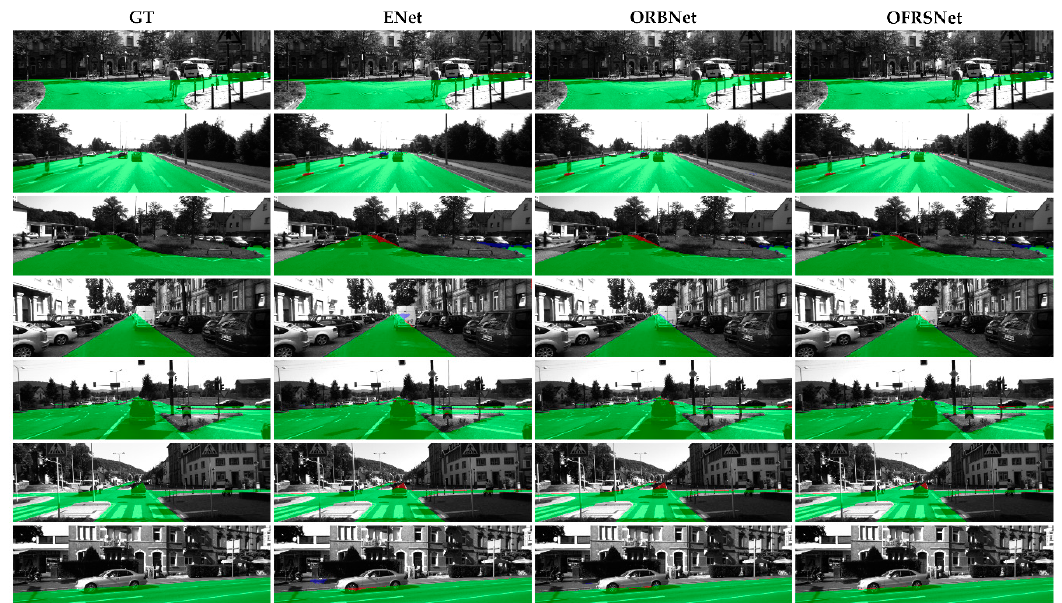
Figure 8. Qualitative results on the KITTI-OFRS dataset. The columns from left to right are the results of GT, ENet, ORBNet, and OFRSNet, respectively. Red denotes false negatives; blue areas correspond to false positives, and green represents true positives. Table 2. Evaluation results of models trained with spatially-weighted cross-entropy loss (CE-SW).